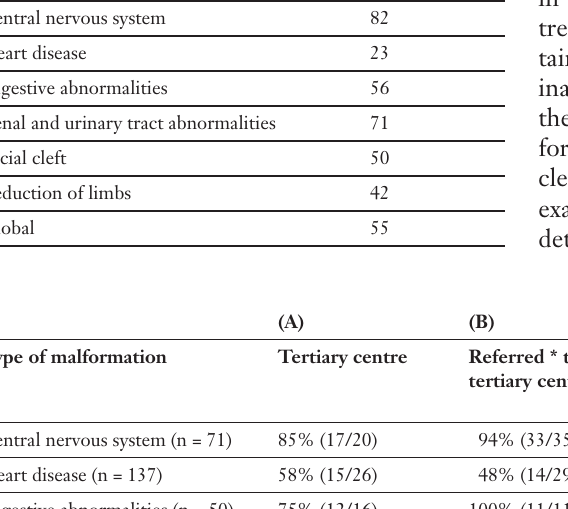
Renal and urinary